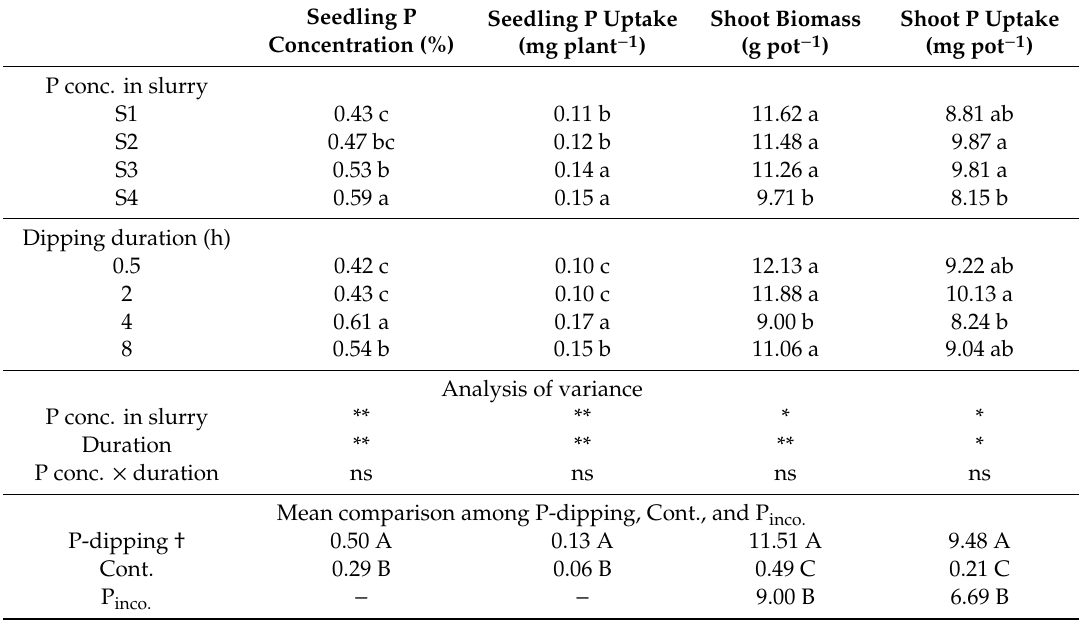
Table 2. E ff ect of P concentration in slurry and dipping duration on seedling P concentration, seedling P uptakes, and shoot biomass and P uptakes at 42 DAT in comparison with Cont. and P inco . treatments. Seedling